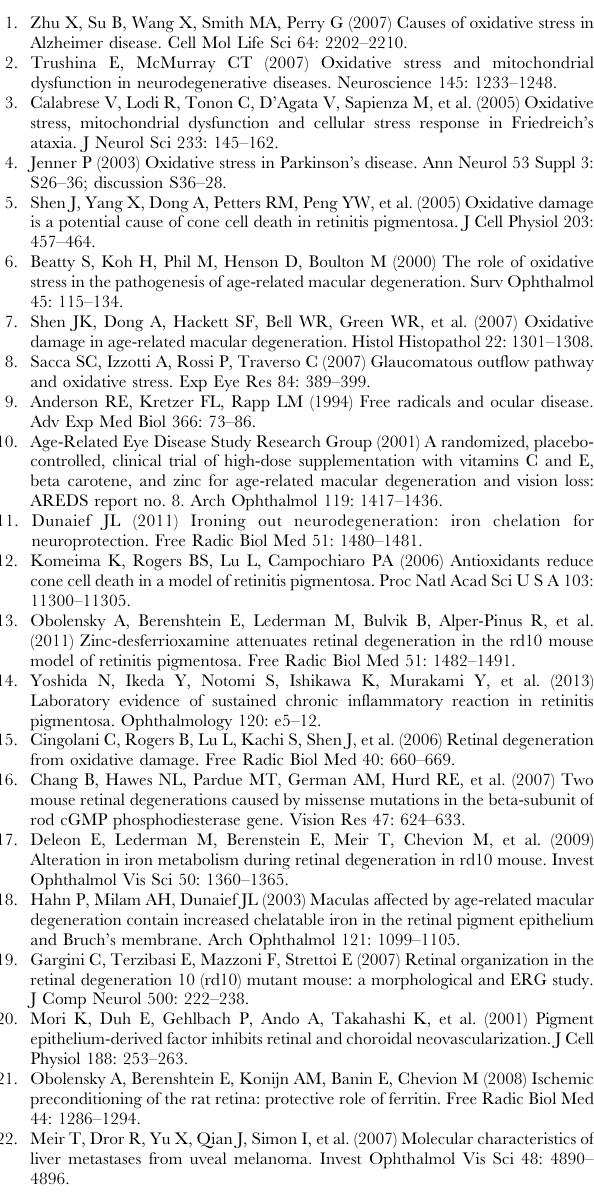
Figure S1 Traces of ERG recordings from WT (C57Bl6) and rd10 mice. The graph shows an example of measurements of b-wave response under scotopic and photopic conditions as well as measurements of 16 Hz flicker ERG response. Cursor position for measurement of the b-wave is